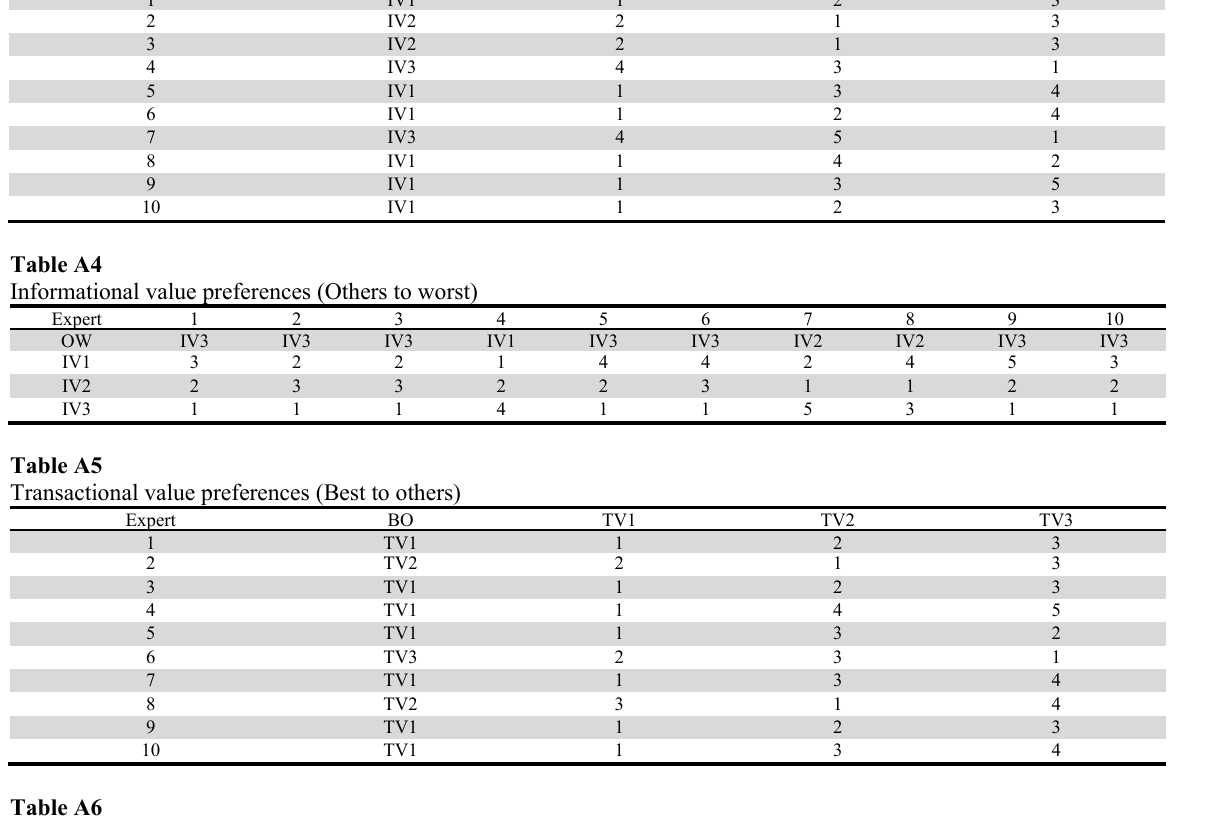
Transactional value preferences (Others to worst) Expert 1